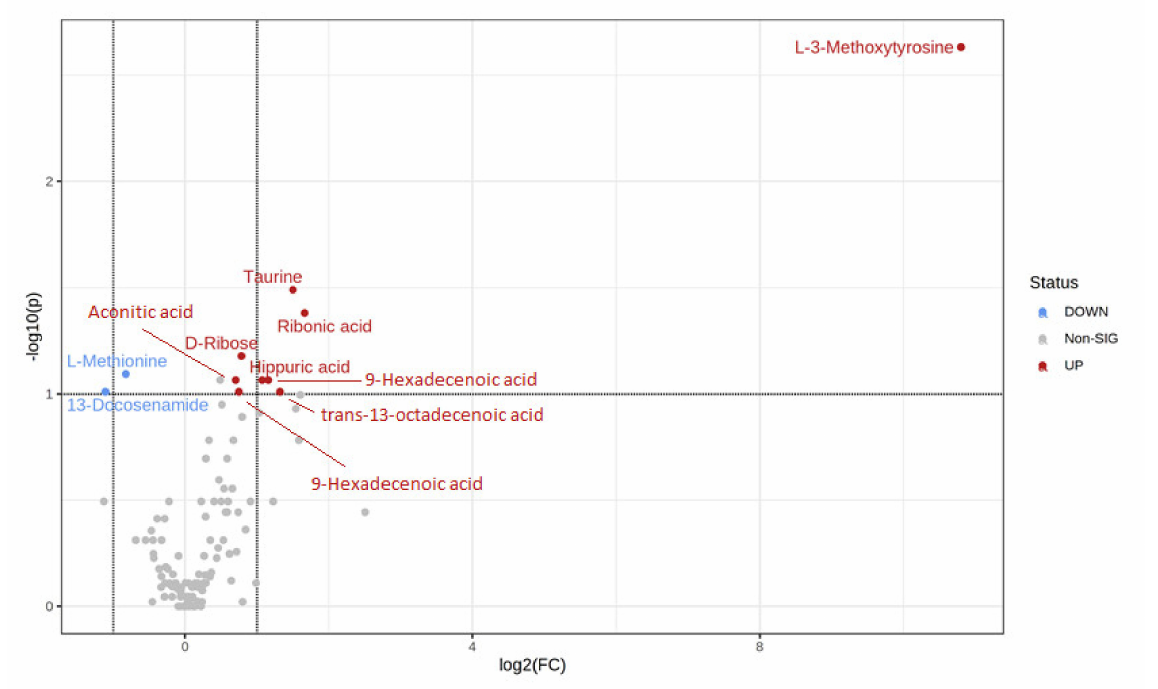
Figure 4. Volcano plot of the plasma metabolites of PD patients and controls, revealing 11 metabolites with a fold-change threshold Log2 > 1.5. Upregulated and downregulated metabolites are in red and blue, respectively. Nonsignificant metabolites are represented by gray dots. X-axis corresponds to log2 (Fold Change) and Y-axis to − log10 ( p